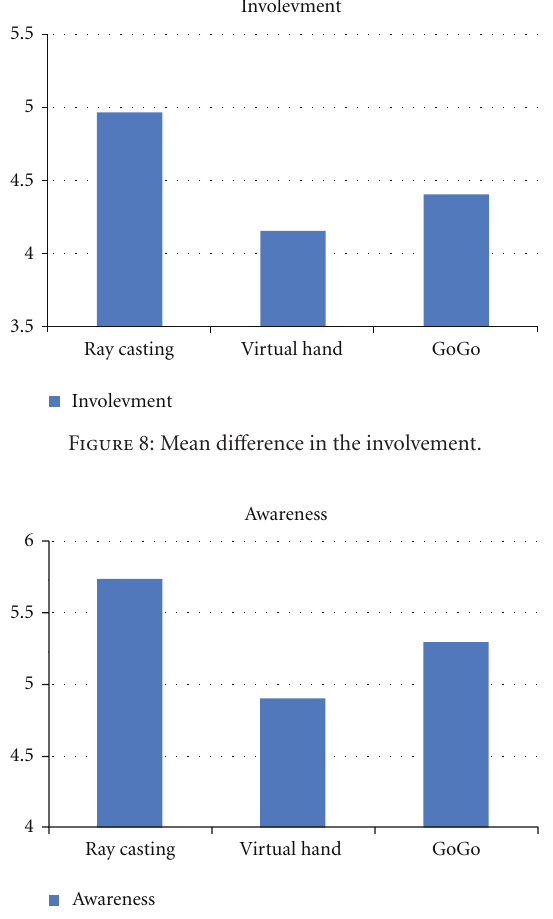
Figure 9: Mean di ff erence in the awareness.